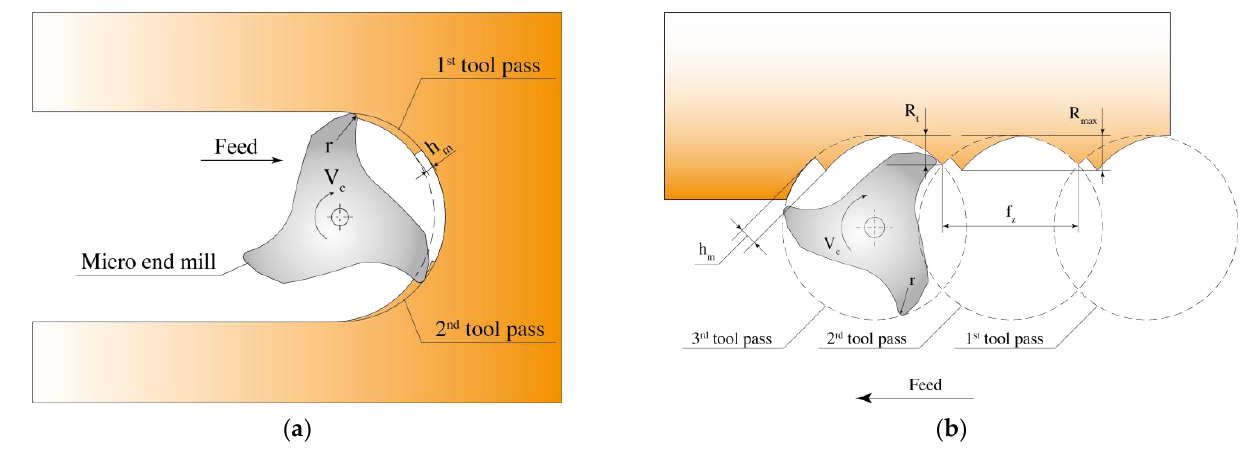
Figure 15. Tool pass in full immersion ( a ) and side micro-milling process ( b ).